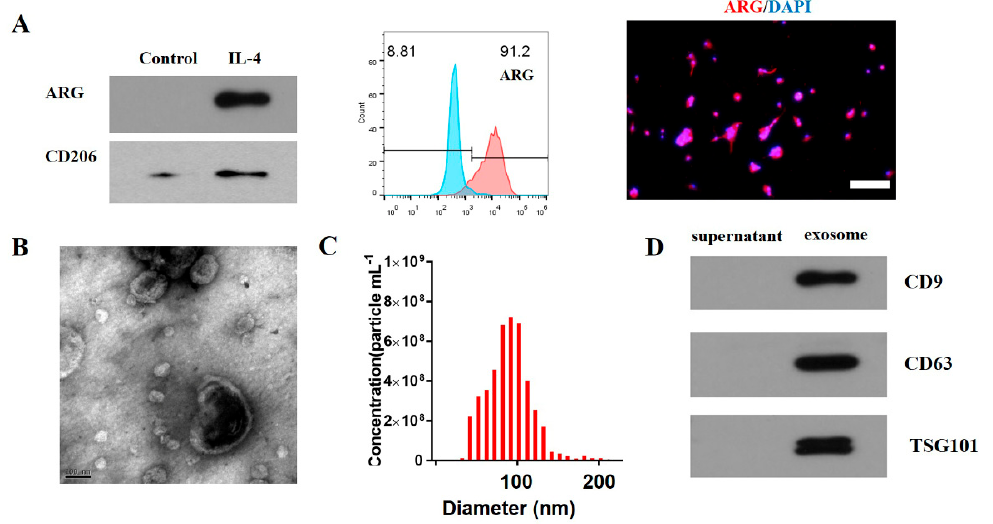
Figure 1. Characterization of M2 macrophages and exosomes. Western blot analysis of ARG and CD206 protein levels ( A ). Flow cytometry showed that 91.2% of cells were ARG+ cells ( A ). Immunofluorescence stain of the surfer markers—ARG (red) of M2 macrophages ( A ). The transmission electron micrograph of exosomes ( B ). The NTA of the exosomes ( C ). The exosome specific markers (e.g., TSG101, CD63, and CD9) were detected by WB ( D ). Scale bar = 100 μ m ( A ). Scale bar = 100 nm ( B ).